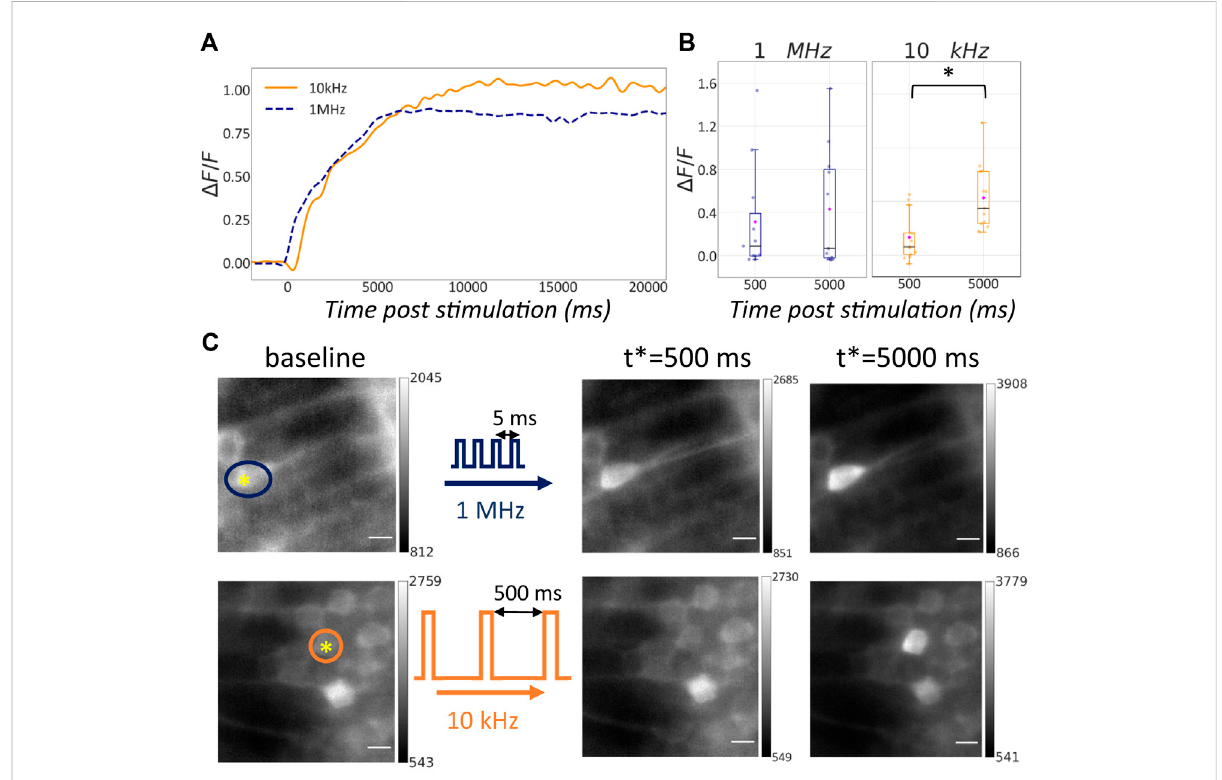
FIGURE 4 Effect of single-neuron ablation in living zebra fi sh embryos with variable repetition rate. (A) Δ F / F 0 signal following photostimulation for two different repetition rates: 1 MHz (blue line), 10 kHz (orange line). (B) Box plots representing the Δ F / F 0 signal at 500 ms and 5 s past stimulation for differentrepetitionrates:1 MHz( n =11),10 kHz(right, n =13).Bluehorizontalbars:medianvalue;magentarhombuses:meanvalues.Groupsmarked withstarshowstatisticalsigni fi cance(Wilcoxonsigned-rankedtest, p =0.007). (C) Lightsheetimagesofrecordedbeforeandat500 msand5 s past stimulation at different repetition rates: 1 MHz (top), 10 kHz (bottom). The yellow asterisk in the baseline images shows the location of the stimulation while the colored circles highlight the cell body to monitor over time. The data sets here reported are the same shown in (A) . Scale bar is 5 μ